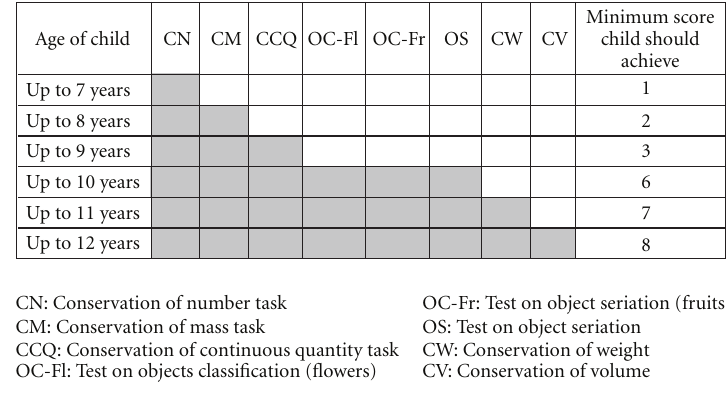
Figure 1: Grading criteria for Piaget’s operation